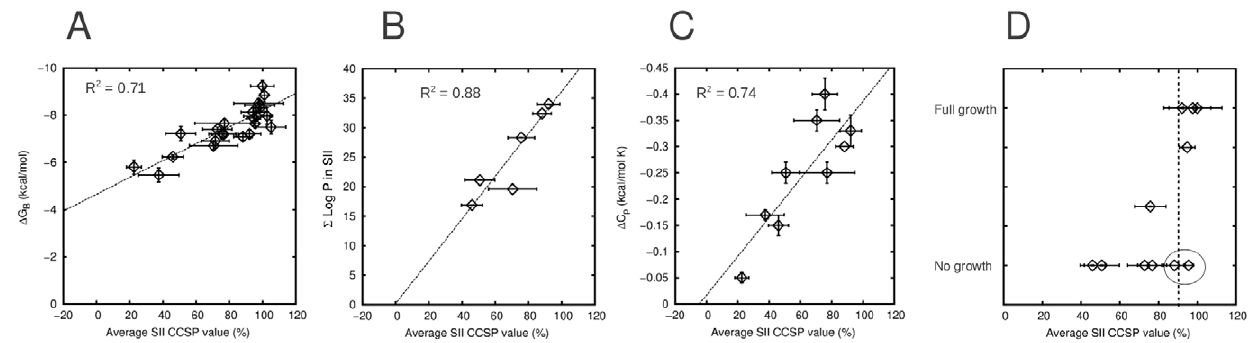
Figure 6. Correlations of thermodynamic and CCSP data. (A) Correlation between global peptide binding energy, D G B , and the average CCSP value for SII for all 24 complexes. (B) Average CCSP value for SII vs. the sum of log (backbone amide protection factors) in SII as measured in H-D exchange experiments ( S LogP in SII). (C) Average CCSP value for SII vs. D C p . (D) Average CCSP value for SII vs. biological growth. The dotted line indicates the possible threshold CCSP value that determines cell growth. The circled data points are the P( 2 2)V and P( 2 2)A complexes which would be expected to have better growth based on their average SII CCSP value (discussed in text). Errors are 6 95% confidence intervals except the D C p values which report the standard error of the least squared fit to the data ( D H vs.